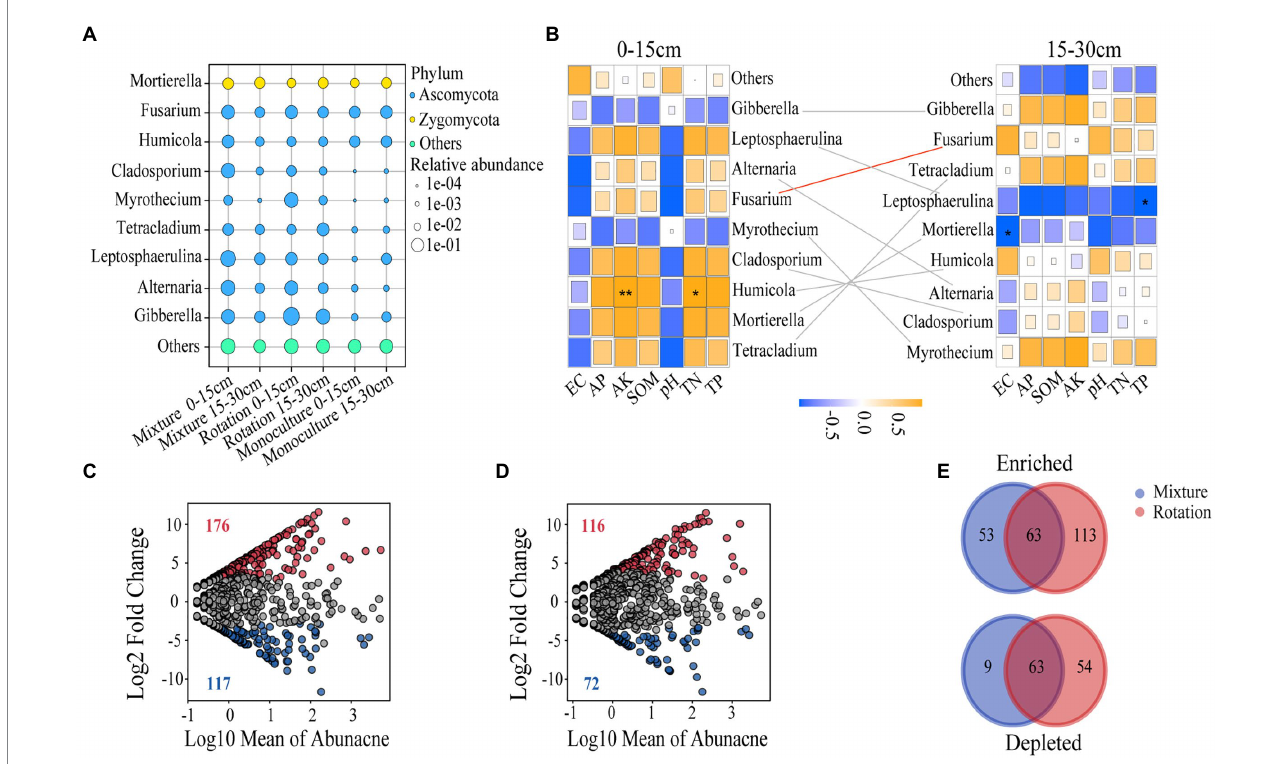
FIGURE 3 The bubble map shows the relative abundance of dominant genera in the fungal community (A) . Correlation heat maps show the correlation between dominant genera and soil chemical properties at 0–15 cm and 15–30 cm soil depths (B) . The red line indicates that soil depth influences the relative abundance of dominant genera, while gray has no effect. Enrichment and depletion of OTUs in rotation (C) and mixture (D) soils compared to monoculture. The number of enriched and depleted OTUs differed between each compartment (E) . * p ≤ 0.05; ** p ≤ 0.01.